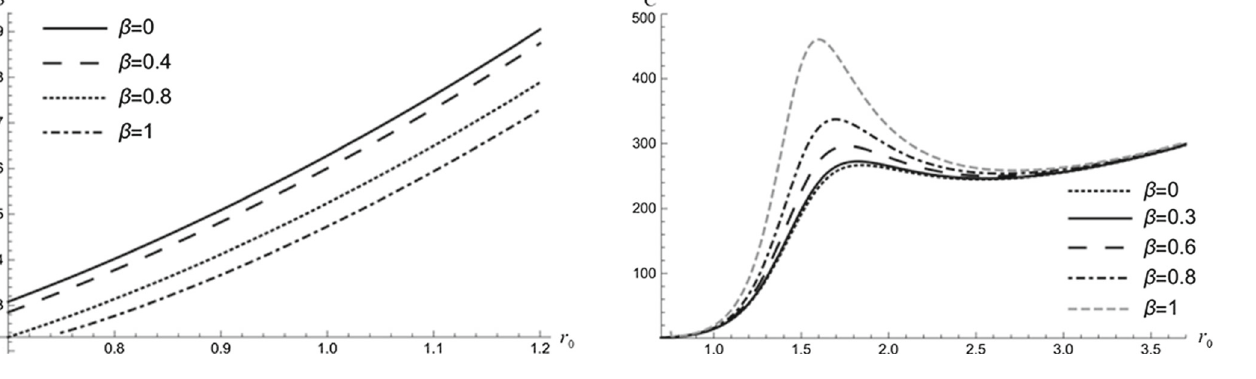
Fig. 4 Entropy vs. r 0 for ¯ h = 1 Fig. 5 The heat capacity vs. r 0 for ¯ h = 1 , Q = 0 . 7 , P = 0 .